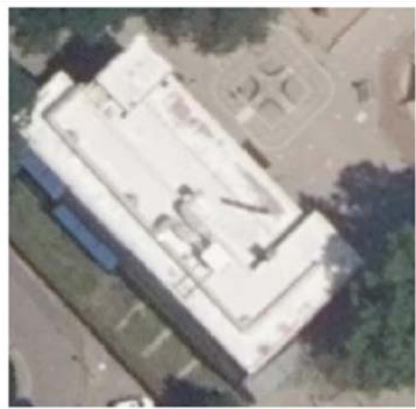
Figure 6 . Aerial ortho-photo of a sample building